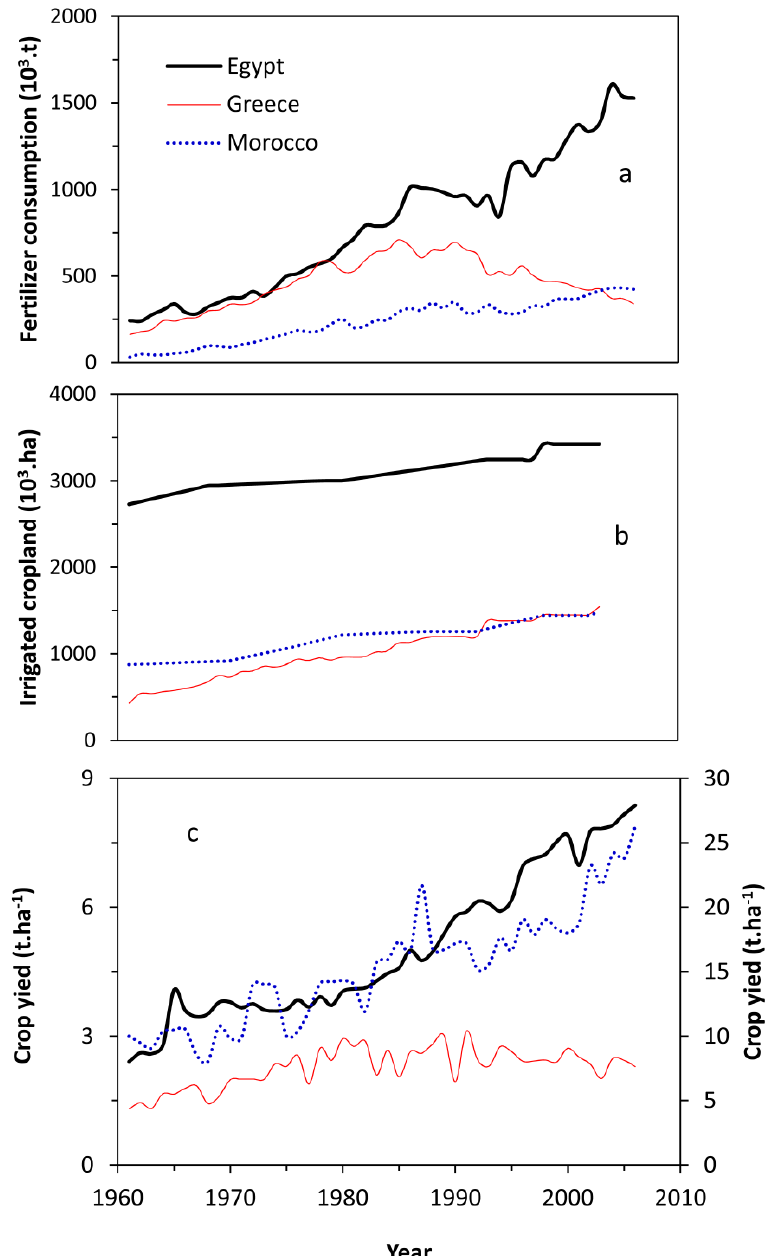
Figure 2. Temporal evolution of total fertilizer consumption ( a ), irrigated cropland ( b ), and crop yield ( c ); between 1961 and 2006 in Egypt, Greece and Morocco. Crop yield refers to maize and wheat crops (primary y -axis) in Egypt and Greece, respectively; and to potato crop in Morocco (secondary y